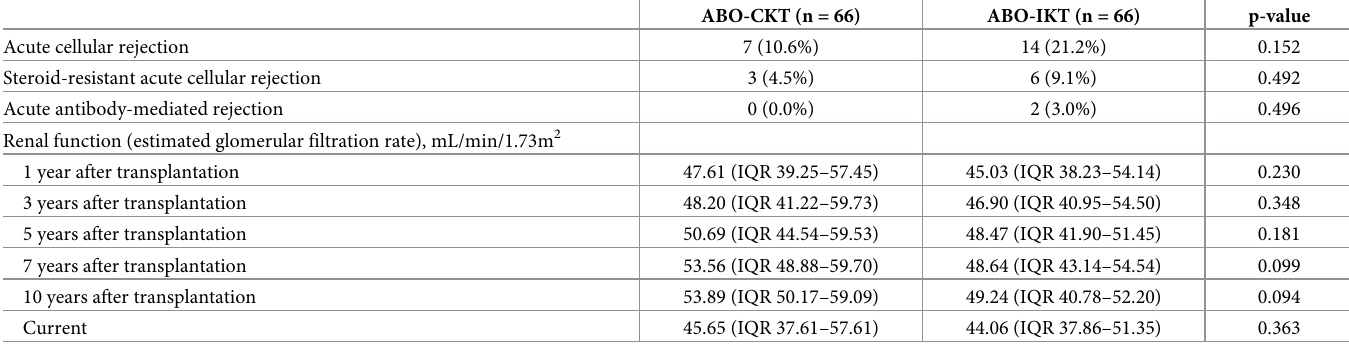
Table 2. Comparison of renal function and rejection episodes between ABO-CKT and ABO-IKT after propensity score